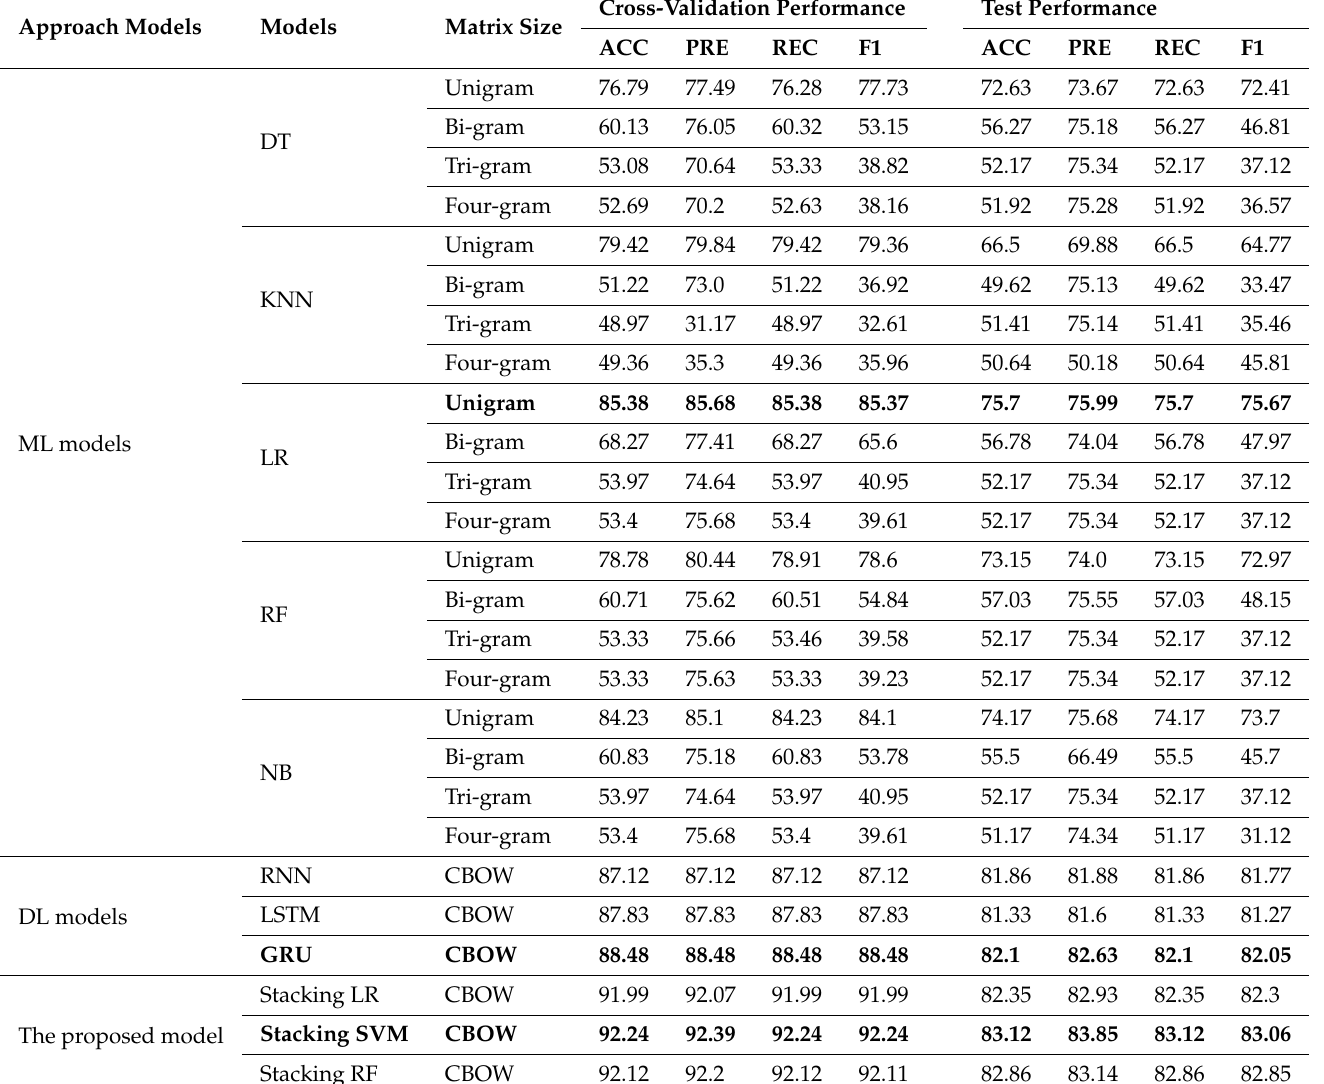
Table 3. The performance results of ML, DL, and the proposed model for dataset ArTwitter. Approach